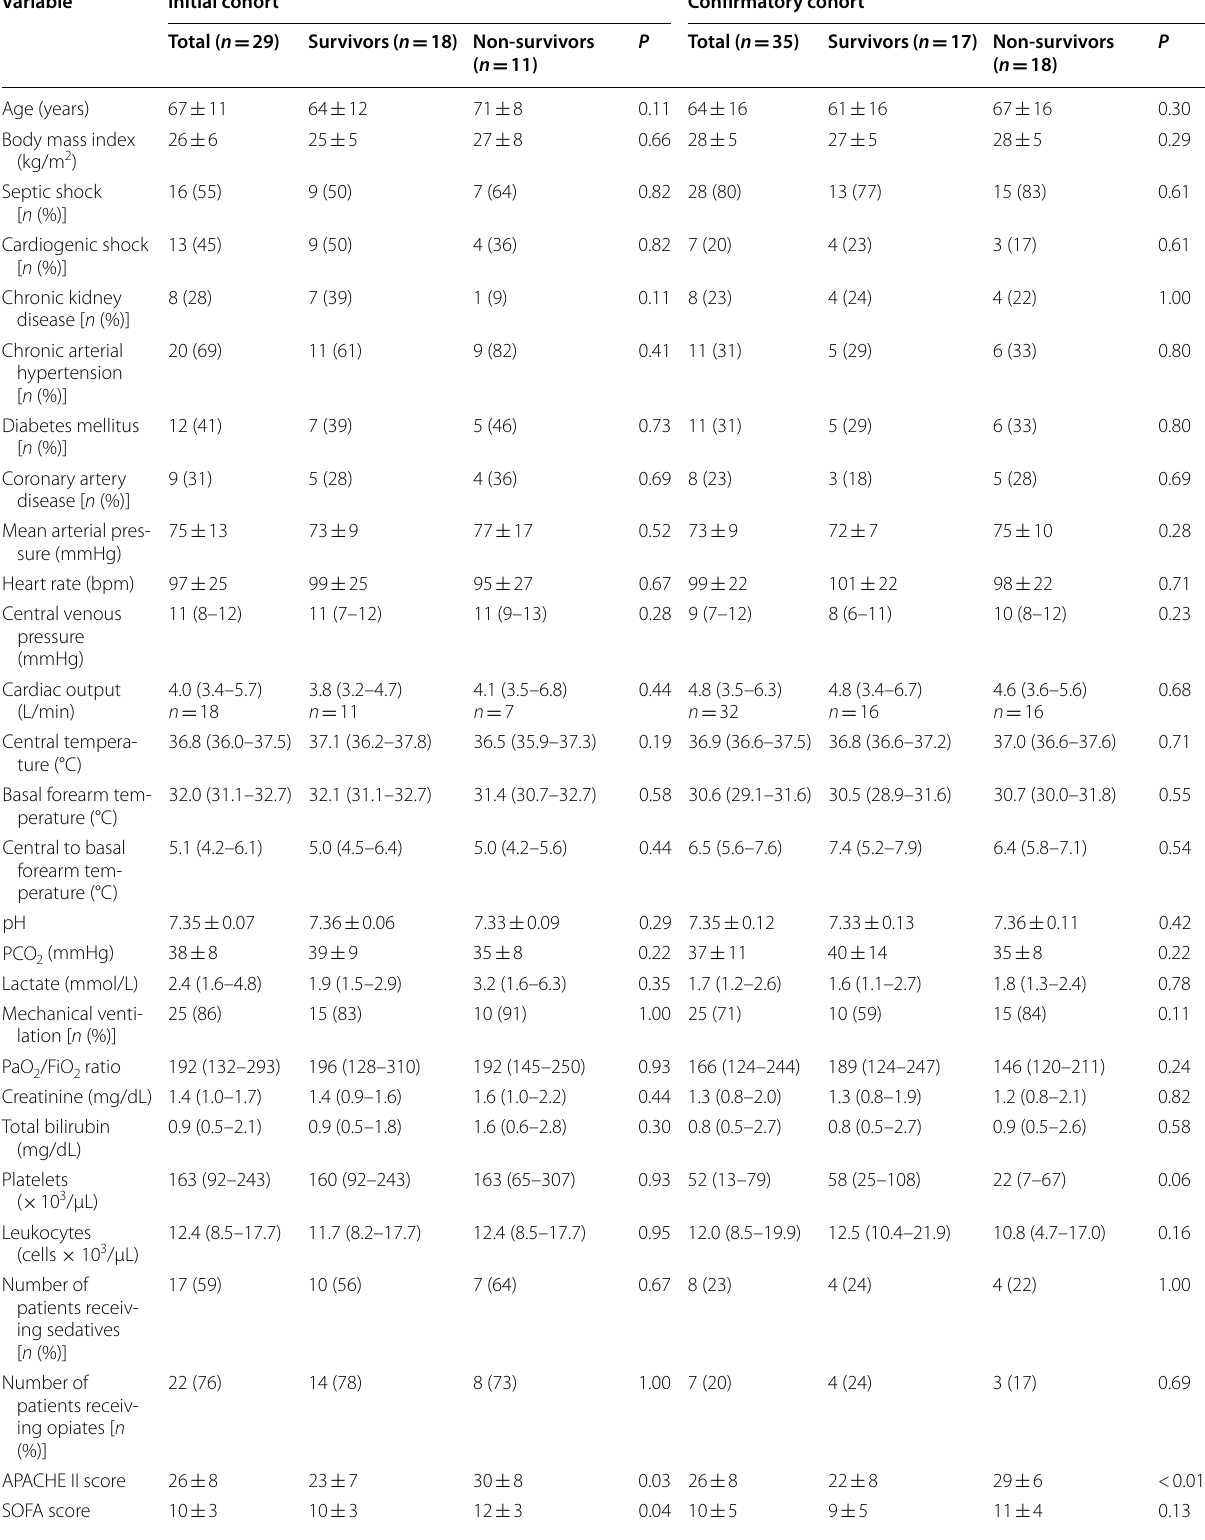
Table 1 Main baseline characteristics of patients with circulatory